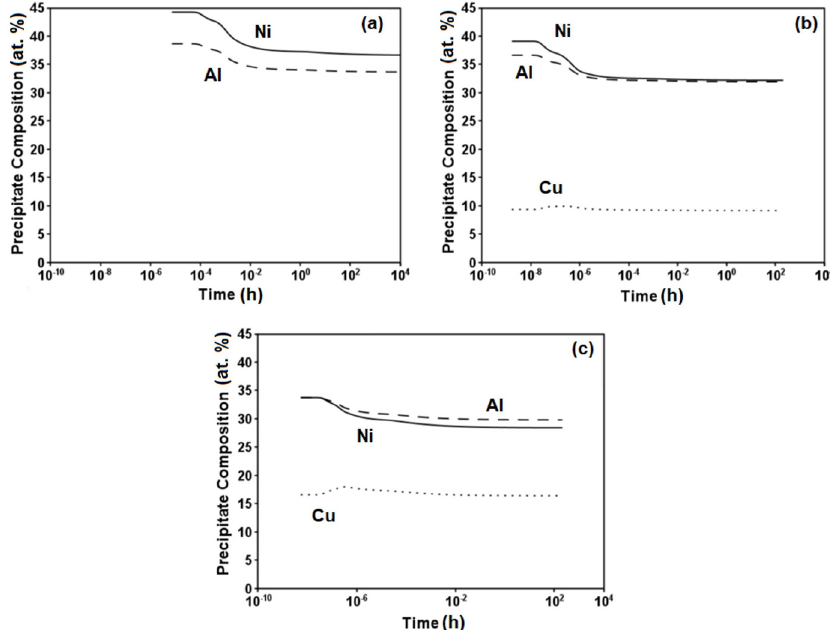
Figure 12. Precipitation/Kinetic software calculated chemical composition of β´precipitates vs. time for the (a) Fe-10at.%Ni-15at.%Al, (b) Fe-10at.%Ni-15at.%Al-2.5at.%Cu and (c) Fe-10at.%Ni-15at.%Al-5at.%Cu alloys aged at 850